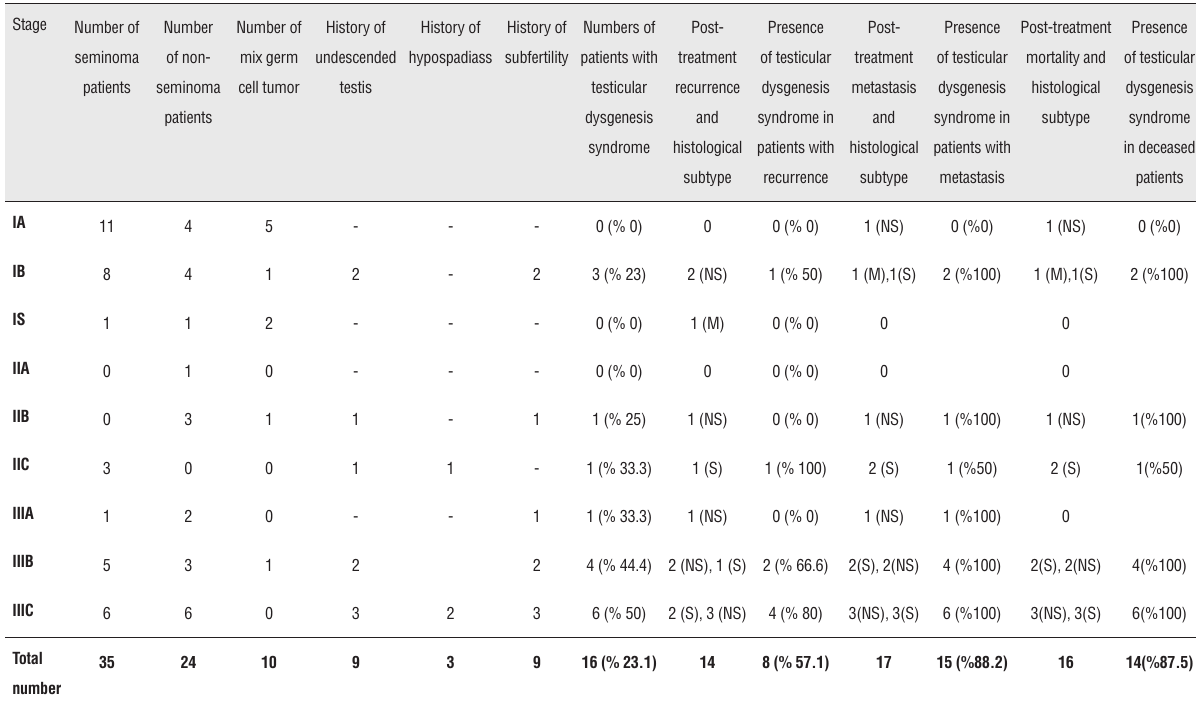
Table 1 - Distribution of patients according to tumor stages, histologic tumor types, components of testicular dysgenesis syndrome and oncologic